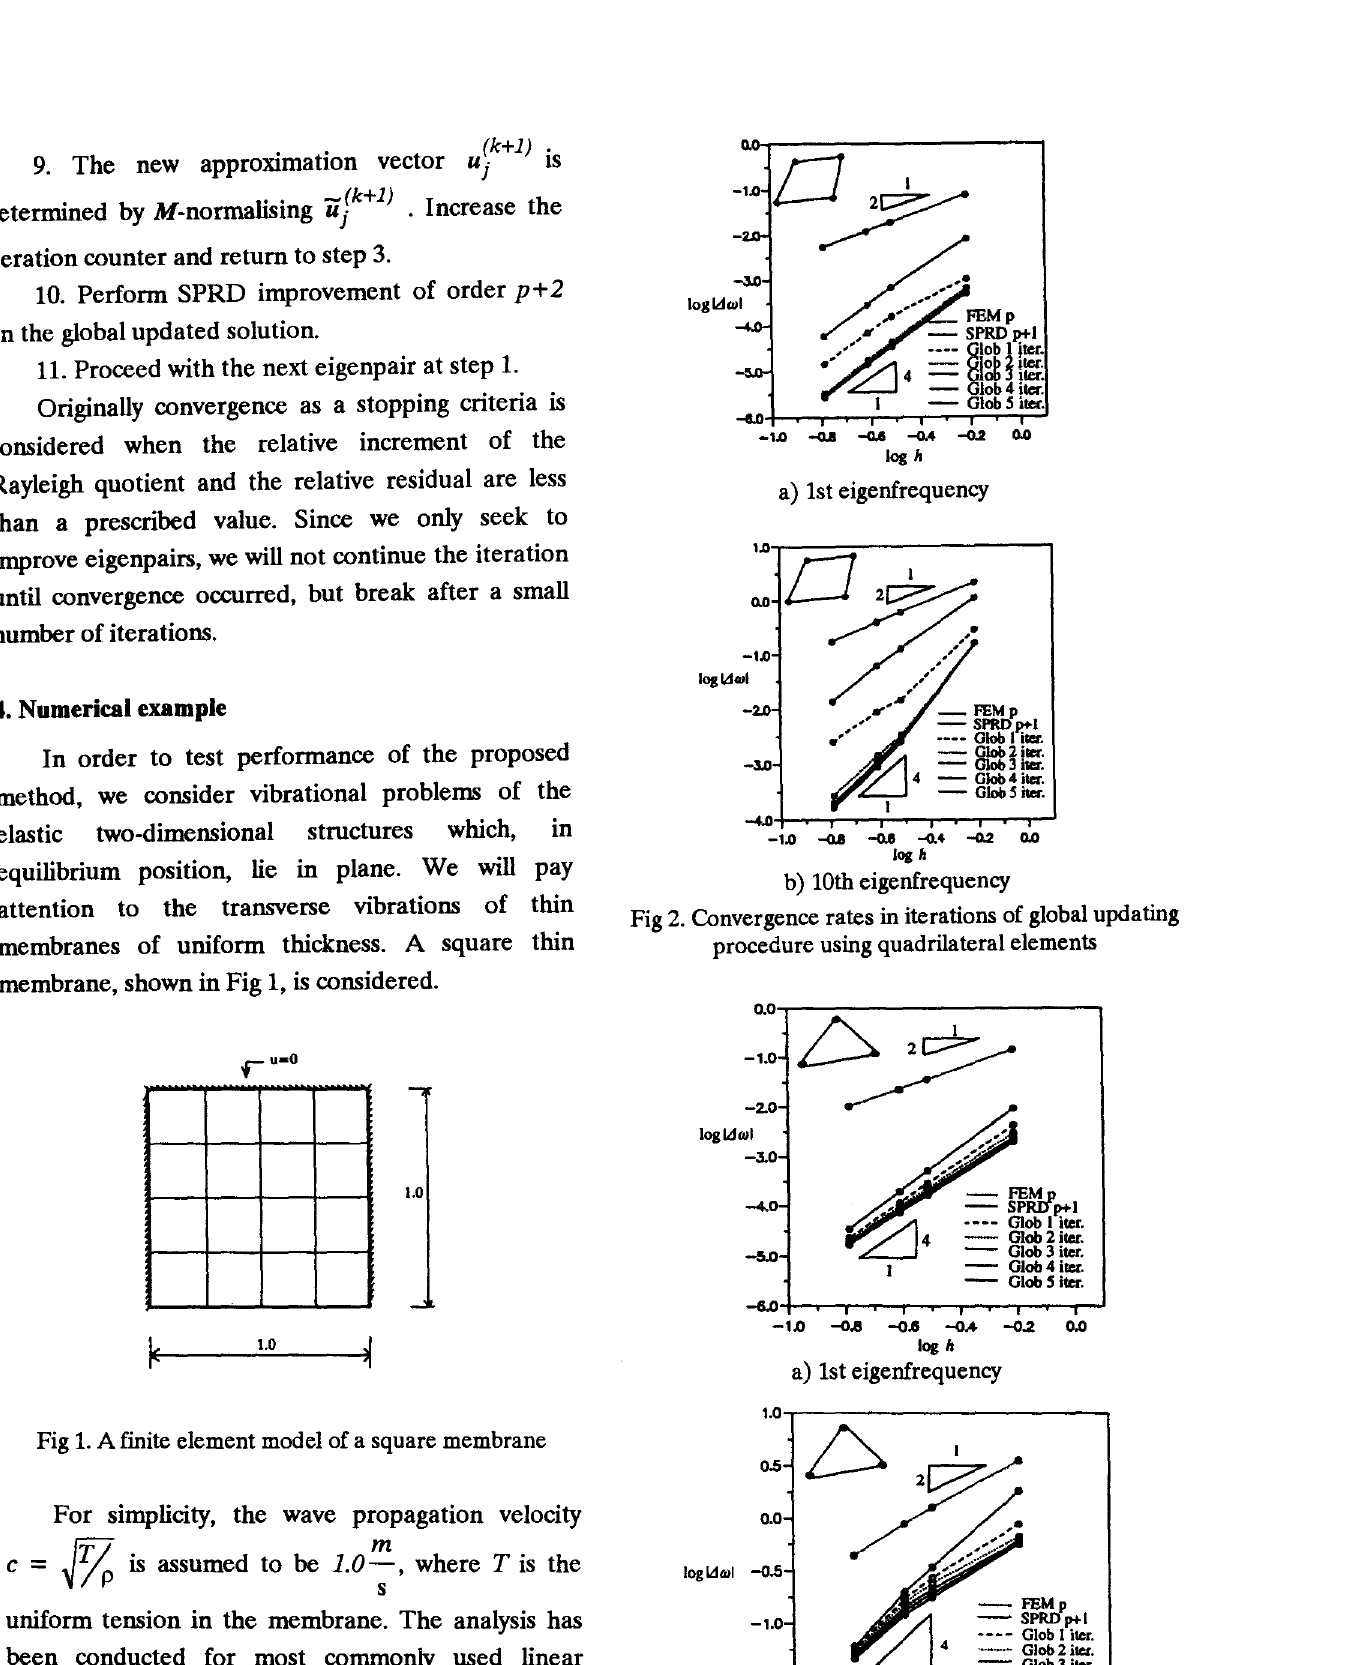
Fig 3. Convergence rates in iterations of global updating procedure using triangular